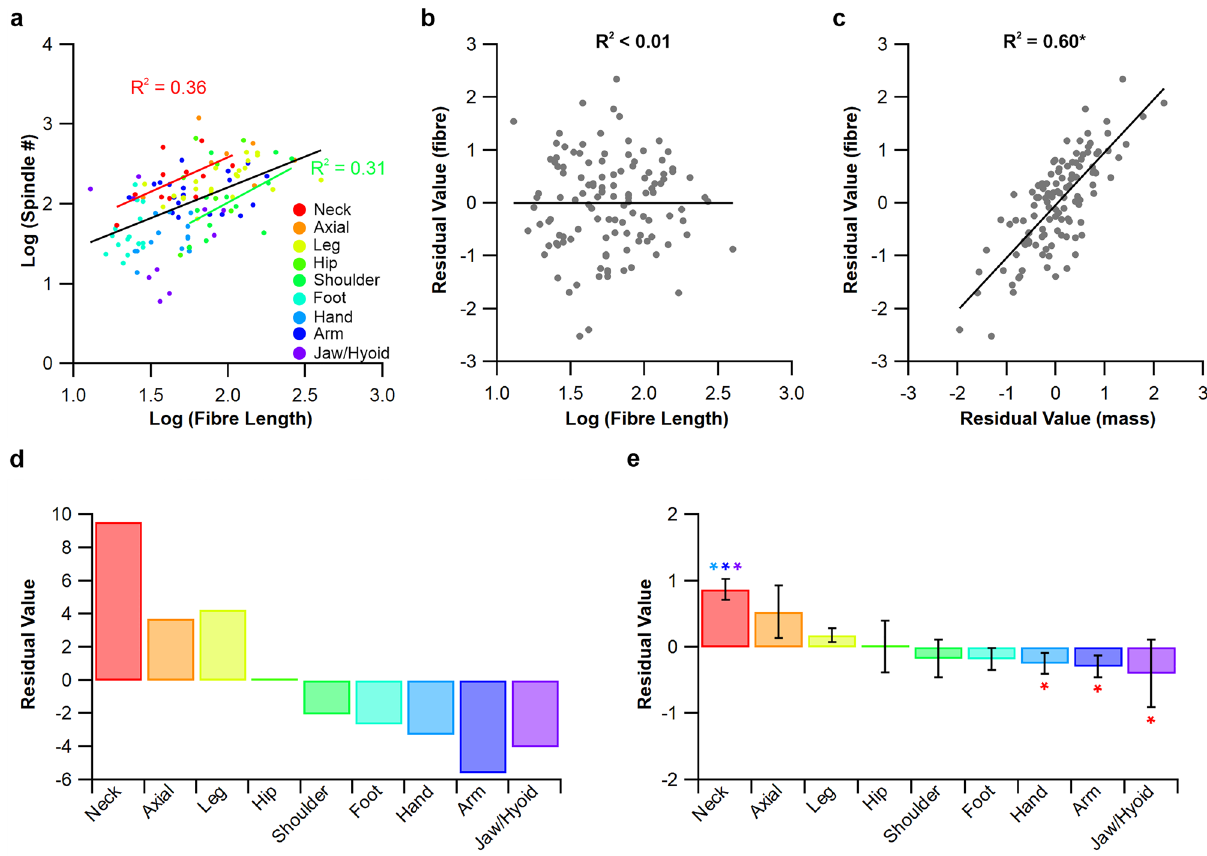
Figure 3. Regional differences in spindle composition. Muscles have been grouped into regions of the body and linear regressions plotted for the neck (red line) and shoulder (green line) ( a ). These data follow an identical trend to those of Banks (2006) where muscles in the neck appear to be more highly abundant in muscle spindles compared to those of the shoulder. Using the grouped data linear regression (black line) residual values have been calculated for each muscle ( b ). Taking the residual values estimated by muscle mass from Banks (2006) and those calculated here for fibre length we show that there exists a significant overlap between the two residual value methods ( c ). This highlights the tightly coupled relationship between muscle spindle number and muscle architecture, while providing further support for the use of residual values as a measure of muscle spindle abundance. The sum ( d ) and average ( e ) residual value across regions highlight the difference in abundance across the body. * P <